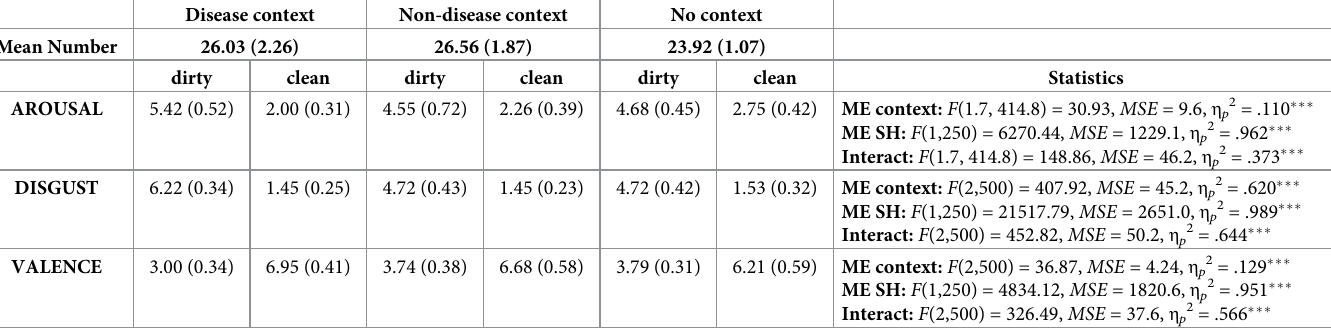
Table 7. Mean number of responses (and SD) obtained per image and mean ratings (and SD) of arousal, disgust and valence in each encoding context. Disease